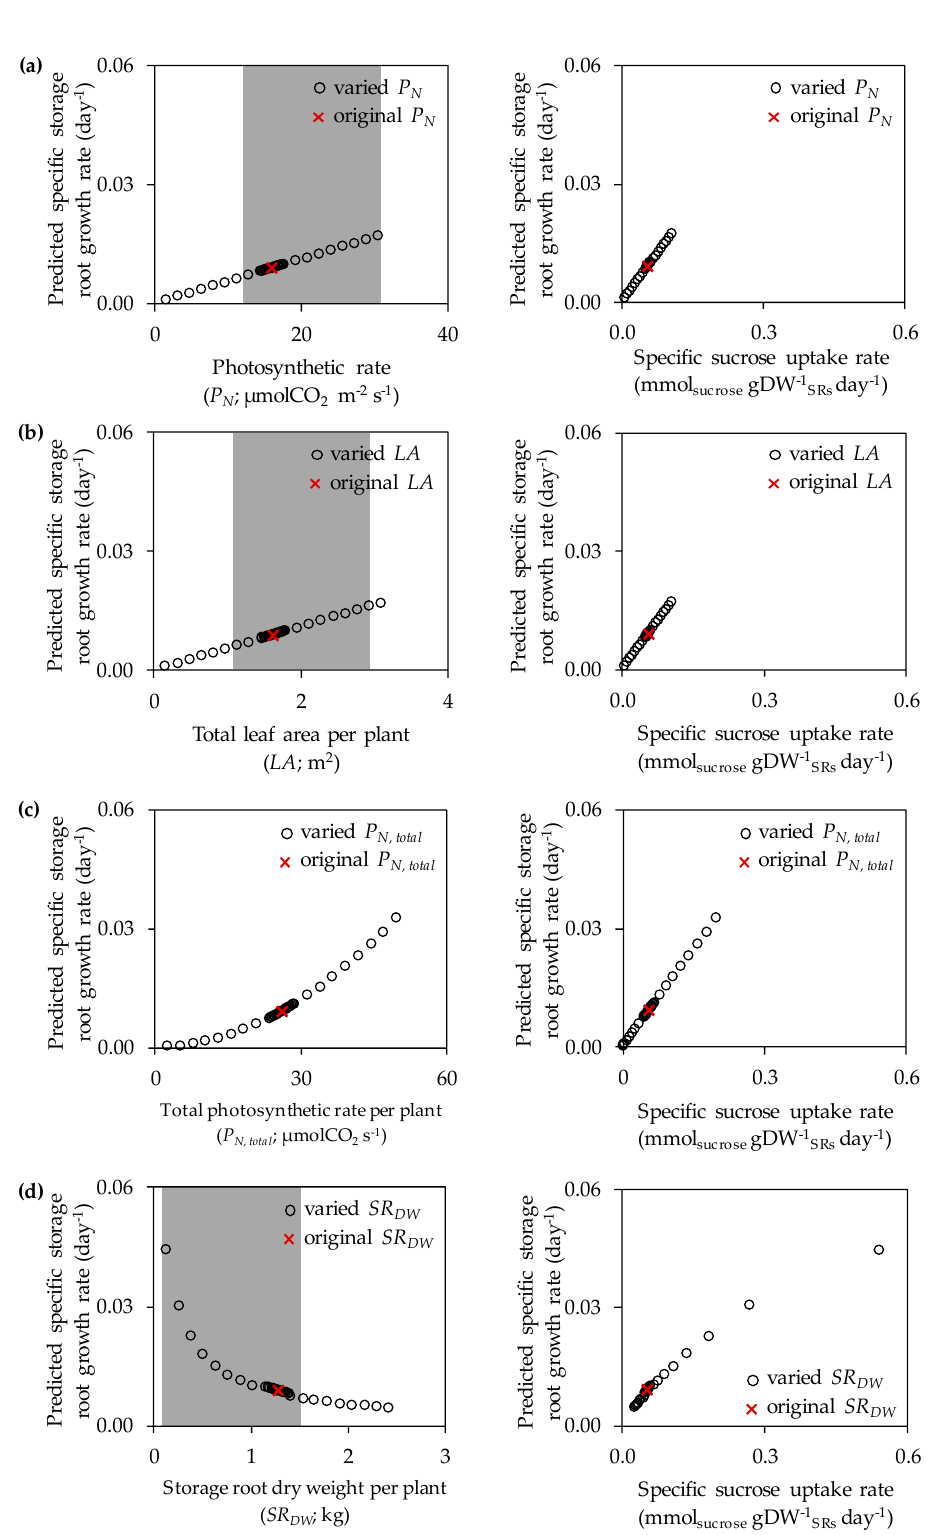
Figure 3. The sensitivity of the predicted specific storage root growth rates to specific sucrose uptake rates (right panel), calculated by varying ( a ) the photosynthetic rate, ( b ) total leaf area, ( c ) total photosynthetic rate, and ( d ) storage root dry weight (left panel) within ± 90% of the original values. Red crosses denote experimentally derived, original model default values, while the areas highlighted in gray indicate the range of possible values reported in the literature [37–43].